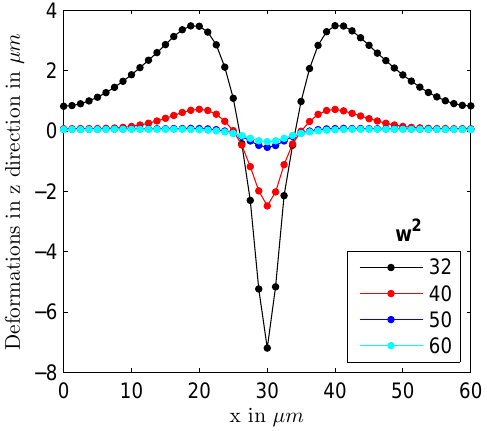
Figure 7. The deformations in z direction for light polarized in x direction at different values of beam radius shown in the